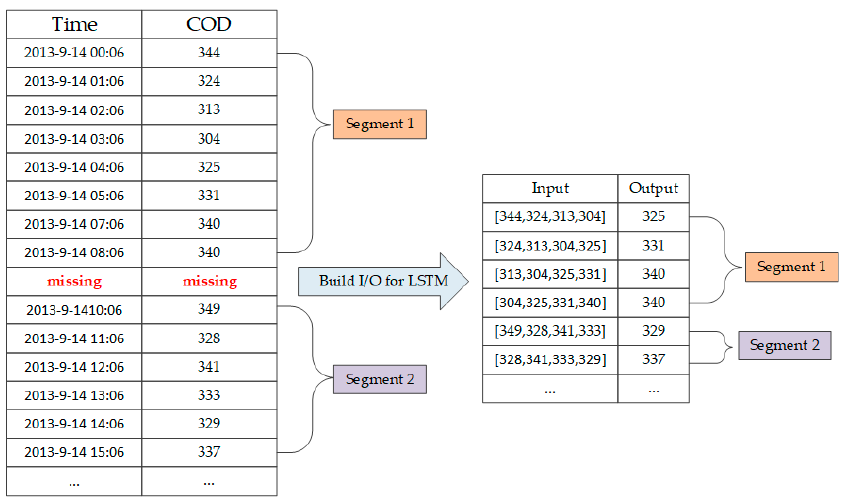
Figure 6. The process of building the input and output datasets for LSTM networks.